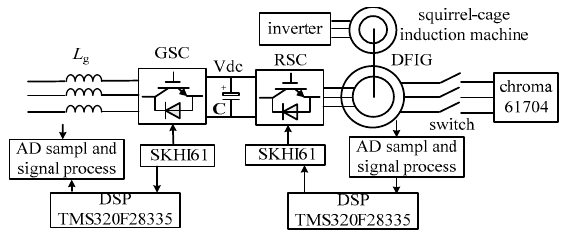
Figure 12. Configuration of test rig. Table 3. Parameters of The Tested System.